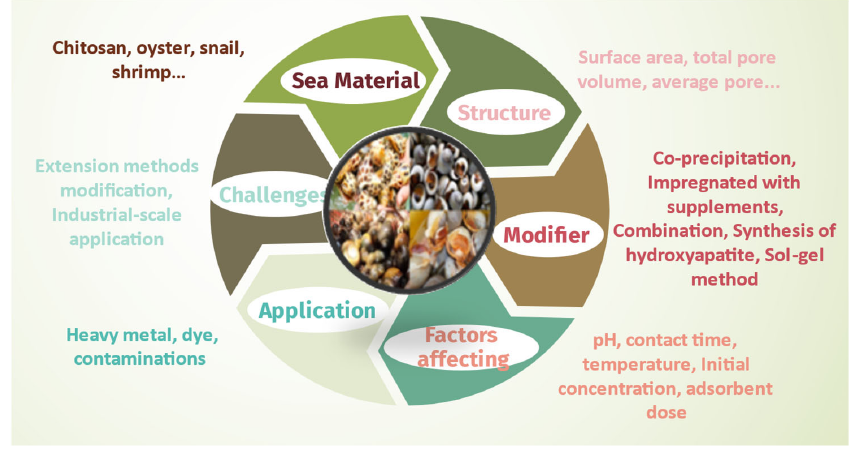
Figure 2. General overview of snail shell materials for wastewater treatment.